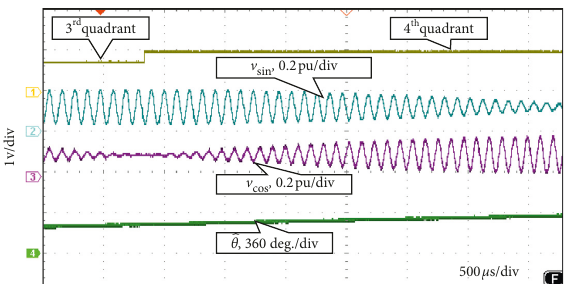
Figure 11: Waveform at 1000rpm rotation speed.